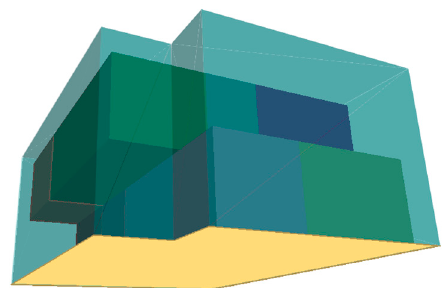
Figure 7. 3D room geometries (random colours), 2D building outline (yellow) and extruded 3D building exterior geometry (transparent blue).